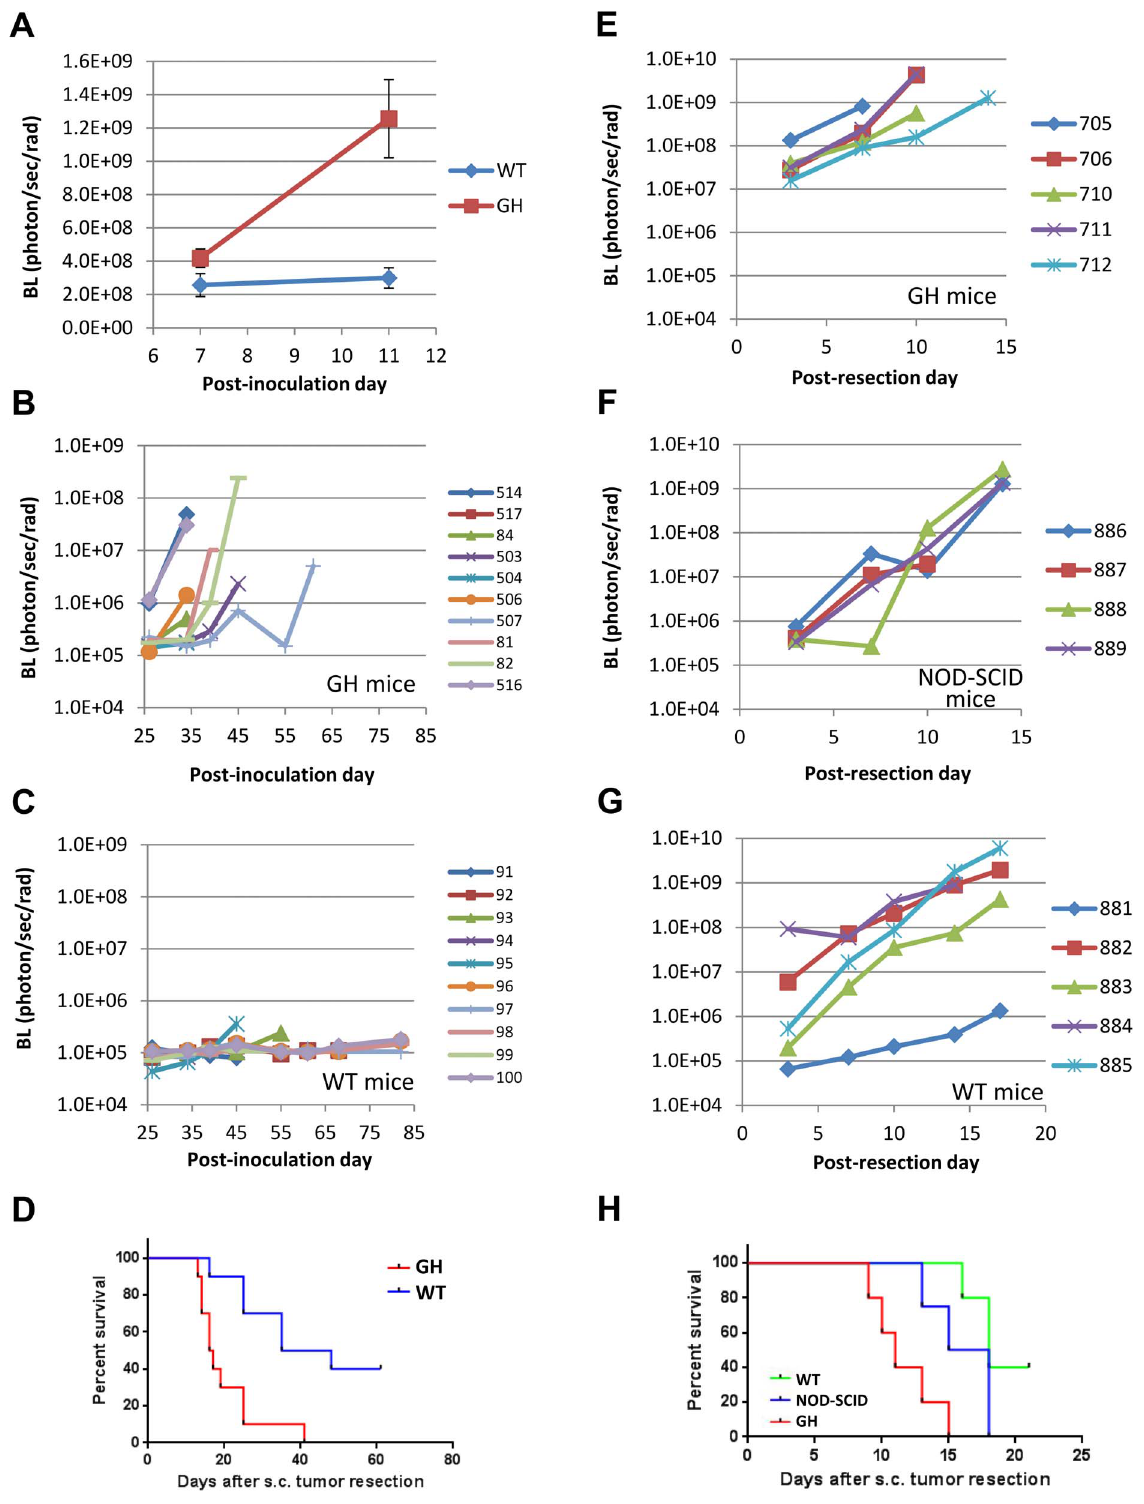
Figure 3. Reporter activity and metastasis of ffLuc-eGFP-labeled cancer cells are consistent in GH mice but suppressed in immunocompetent wildtype mice. A–D , Functional comparison of GH and WT mice as transplantation hosts using a breast cancer model. The GFP + population from ffLuc-eGFP-transduced Mvt1 mouse breast cancer cells was isolated and expanded in culture. 1 6 10 5 cells were injected into the mammary fat pads (m.f.p.) of WT and GH syngeneic FVB/N mice, followed by BL imaging to monitor tumor growth. Though tumors grew in the fat pads of both groups, the BL intensity (mean 6 SE) of those in WT mice was highly suppressed relative to GH mice ( A ). *, P =0.083; **, P , 0.001. ( B– C ) Upon reaching 500 mm 3 m.f.p. tumors were resected, and BL imaging was used to monitor metastatic progression, which is visualized by body BL signal in each mouse. Metastatic disease progressed consistently in GH mice ( B ), while being suppressed in WT mice ( C ); the sign and number at side